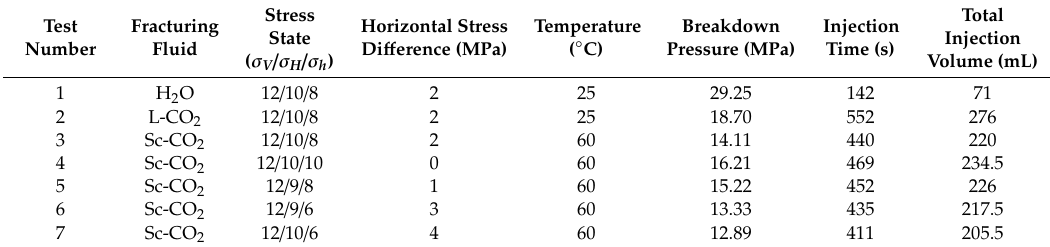
Table 3. Experimental conditions and results for fracturing